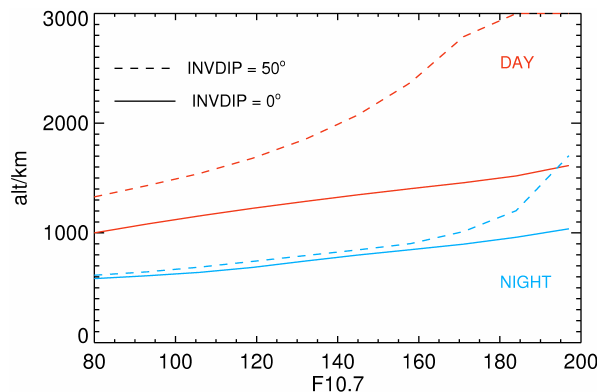
Fig. 10. Solar activity dependence of the upper transition height where n(O + )+n(N + )=n(H + )+n(He + ) for equator and mid-latitudes as follows from the TTS